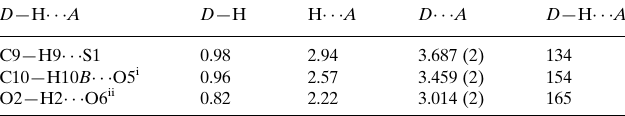
Hydrogen-bond geometry (A˚ , (cid:2)